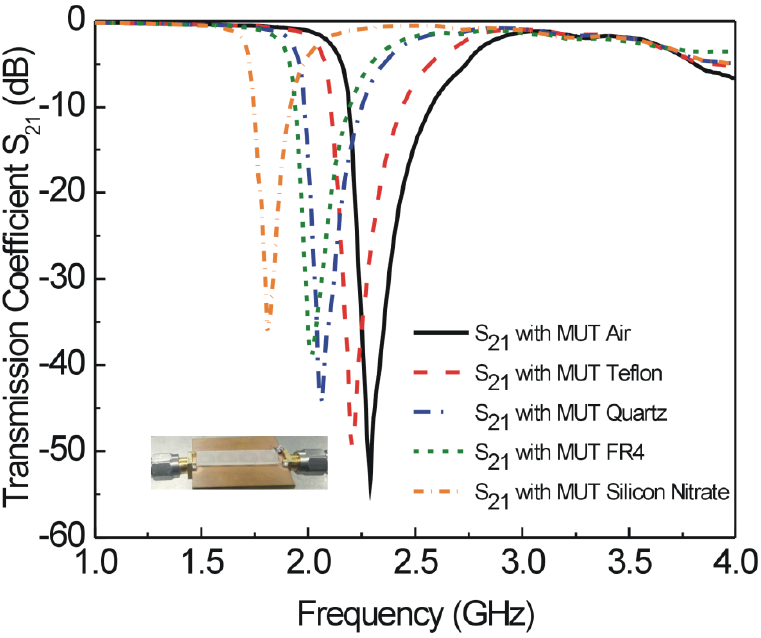
Figure 11. Measured transmission coefficient S 21 (dB) of sensor due to interaction with different MUTs. Resonance frequencies of sensors due to interaction with air, teflon, quartz, FR4, and silicon nitrate are 2.29 GHz, 2.20 GHz, 2.06 GHz, 2.02 GHz, and 1.82 GHz, respectively.